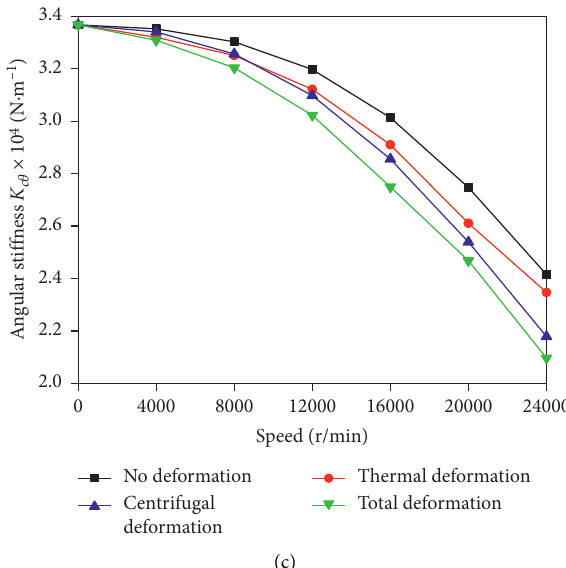
Figure 19: Influences of the speed and deformation on contact stiffness. (a) Radial stiffness. (b) Axial stiffness. (c) Angular